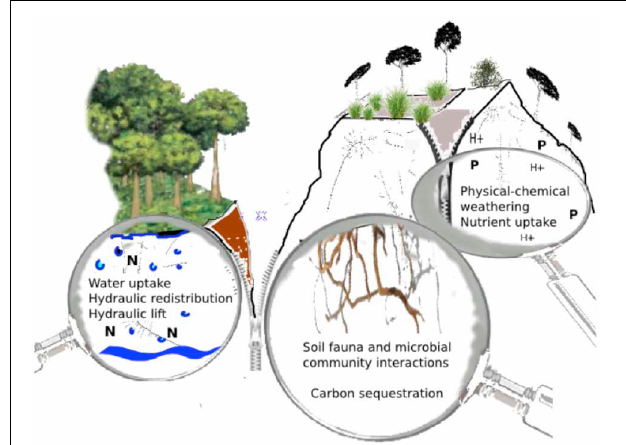
FIGURE 1 | Summary of major impacts of deep roots on the subsoil and deep roots’ functions, i.e., water uptake and hydraulic redistribution, nutrient uptake, physical–chemical weathering and C sequestration, and deep root-fauna and -microbial interactions. See text for further